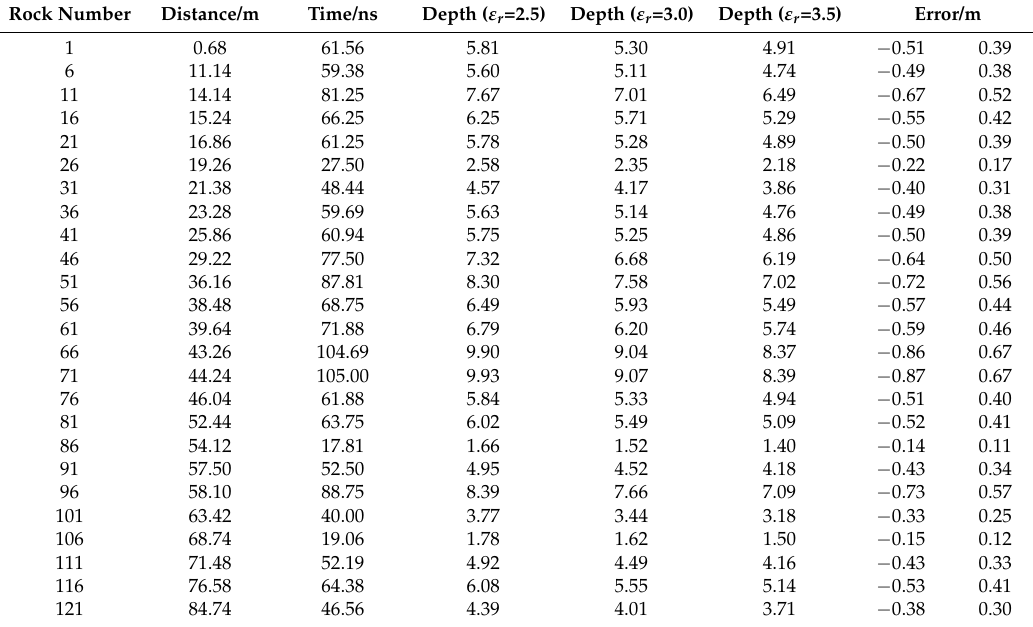
Table A2. Rock depth with different dielectric